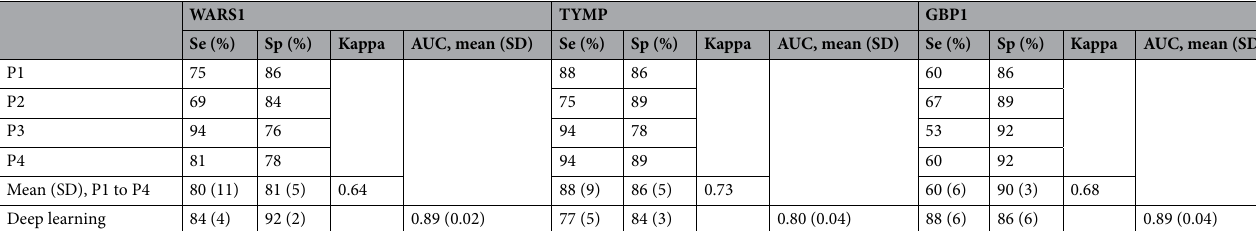
Table 2. Overall performance of the pathologists and of a deep learning-based classification approach in the diagnosis of ABMR with the WARS1, TYMP and GBP1 antibodies by immunohistochemistry. Slides were interpreted by four nephropathologists (B.C., A.V., M.R. and JP.DVH.). They were unaware of the diagnosis and should assess each case as positive or negative for an active ABMR diagnosis based on the recognition